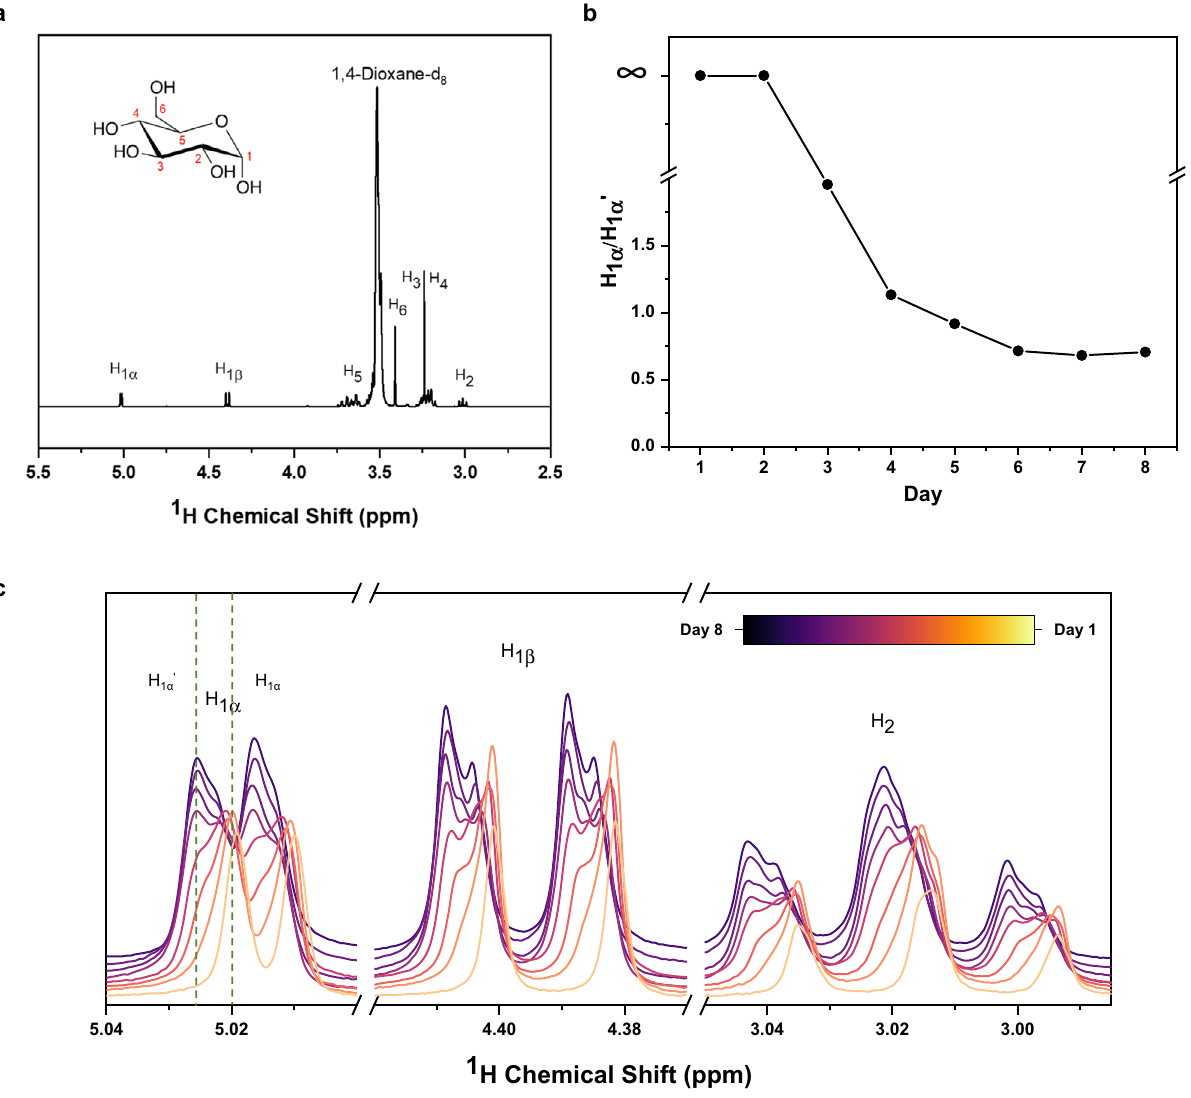
Fig. 3 1 H NMR analysis probing the glucose – Li 2 S 6 interactions within a simulated battery environment. a Full 1 H NMR spectrum for the glucose/ Li 2 S 6 composites. b The proportional evolution between H 1 α and H 1 α ̍ over 8 days. c 1 H NMR spectra over 8 days.